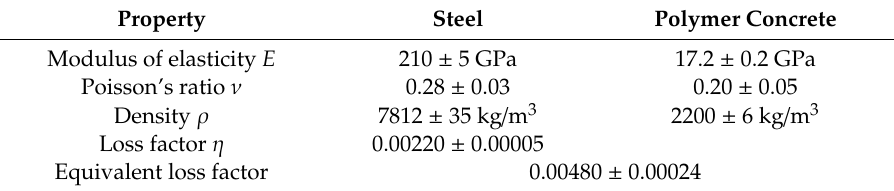
Table 3. Material properties of the steel and polymer concrete determined experimentally.